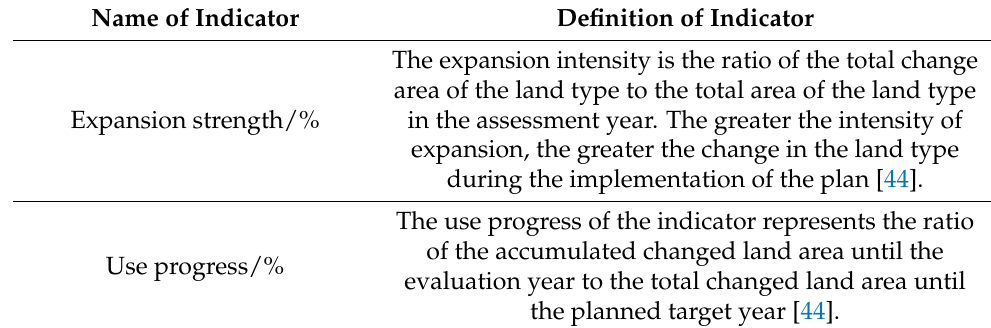
Table 2. Connotation of Speed